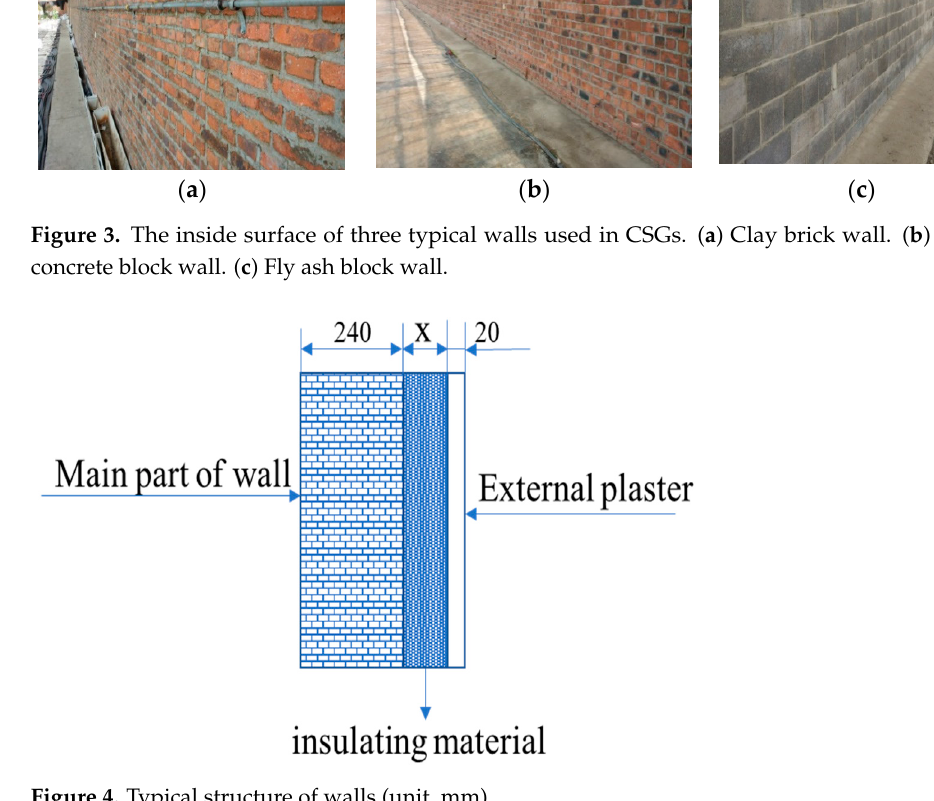
Figure 4. Typical structure of walls (unit, mm).